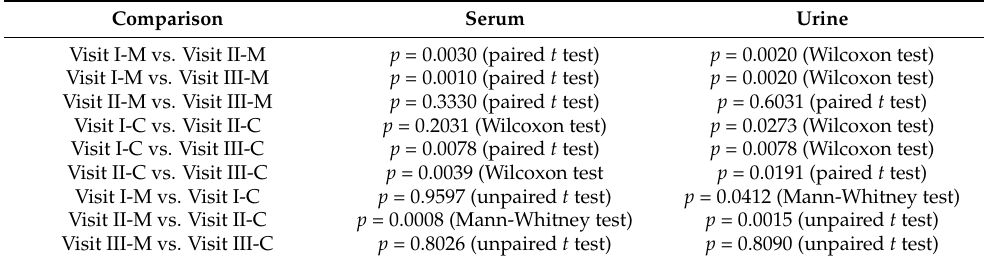
Figure 5. Concentrations of metformin in the serum ( A ) and of creatinine-corrected excretion rates in urine ( B ) of the BMD patients at baseline (Visit I) and after drug administration at Visit II and Visit III in the metformin (M) and citrulline (C) groups. Data are shown as median with 95% CI. Only statistical significances are shown (Mann–Whitney test). The concentrations of creatinine in the urine samples were measured by GC–MS and have been reported elsewhere [13]. Table 1. Summary of the results of statistical comparisons of metformin concentration in the serum and urine of the BMD patients of the metformin (M) and citrulline (C) groups at Visit I, Visit II, and Visit III.